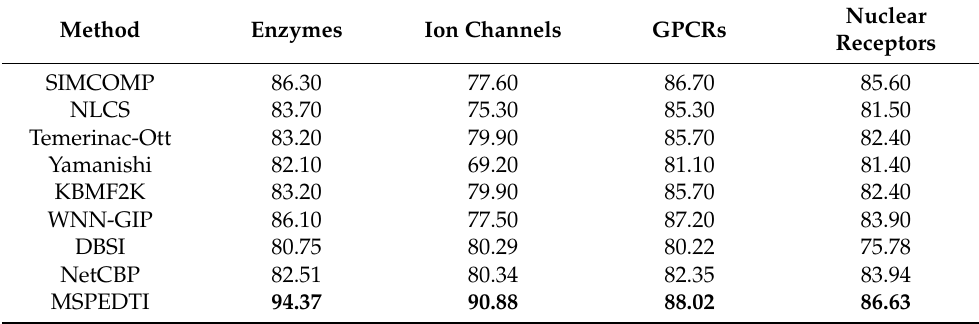
Table 8. Comparison of AUC with previous methods in the gold-standard dataset.